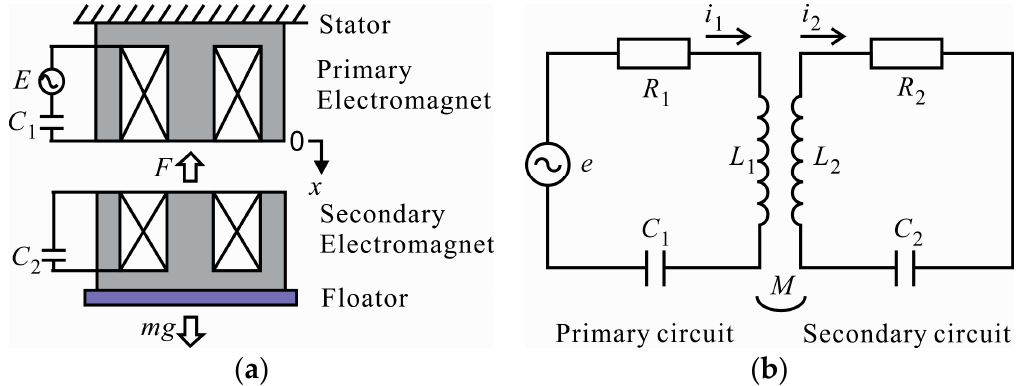
Figure 1. Schematic diagram of AC magnetic suspension using magnetic resonant coupling: ( a ) basic model of magnetic suspension; ( b ) equivalent circuit of the basic model.